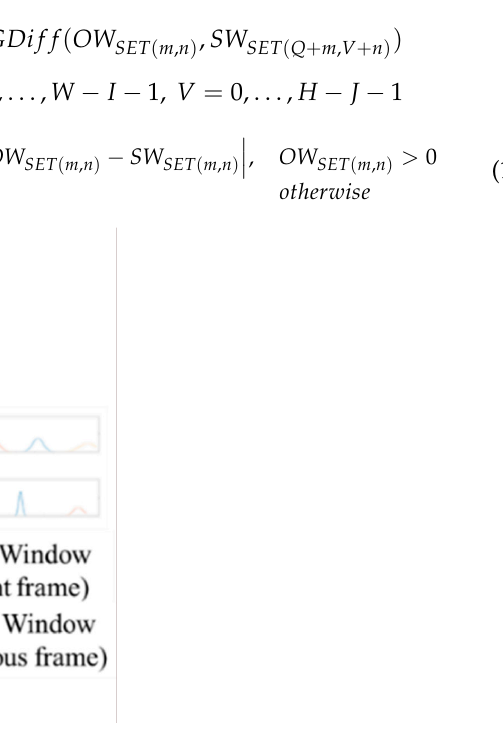
Figure 9. Searching window and object